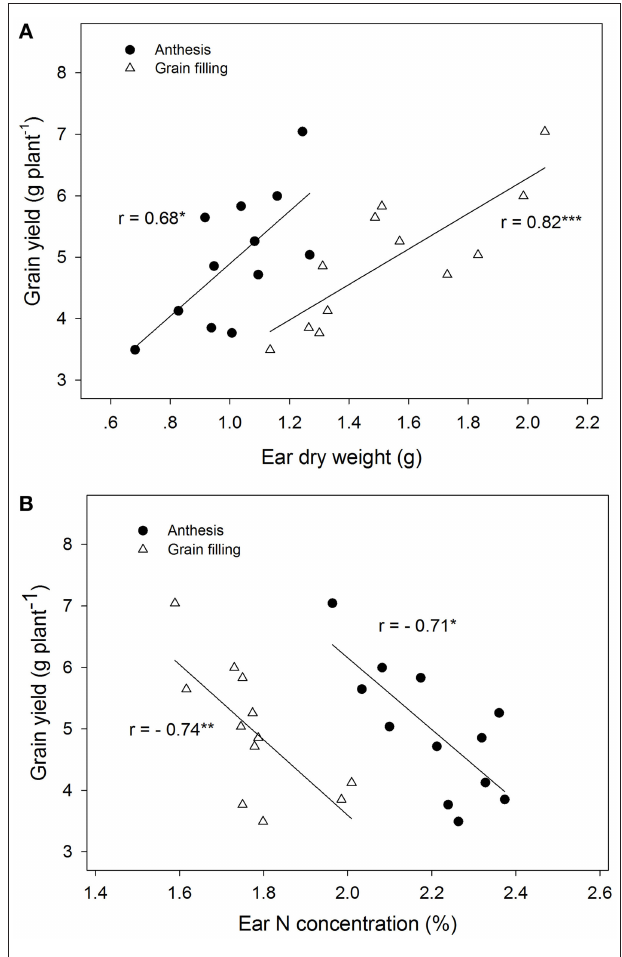
FIGURE 2 | Linear correlations between grain weight and ear dry weight of each plant (A) and ear nitrogen concentration (B) during anthesis and grain filling for four Chinese winter wheat genotypes. (* P < 0.05; ** P < 0.01; *** P <